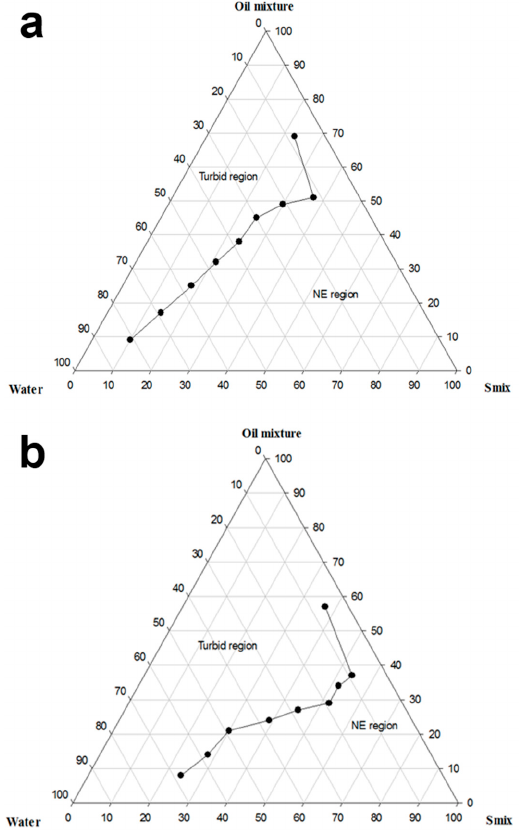
Figure 1. Pseudo-ternary phase diagram of ( a ) system B (Capmul-MCM-EP:Labrafac-lipophile WL 1349 (1:1) ( w / w )-Labrasol:Cremophor EL (1:1) ( w / w )-Water) and ( b ) system C (Capmul-MCM-EP:Labrafac-lipophile WL 1349 (1:1) ( w / w )-Labrasol:Poloxamer-407 (2:1) ( w / w )-Water).